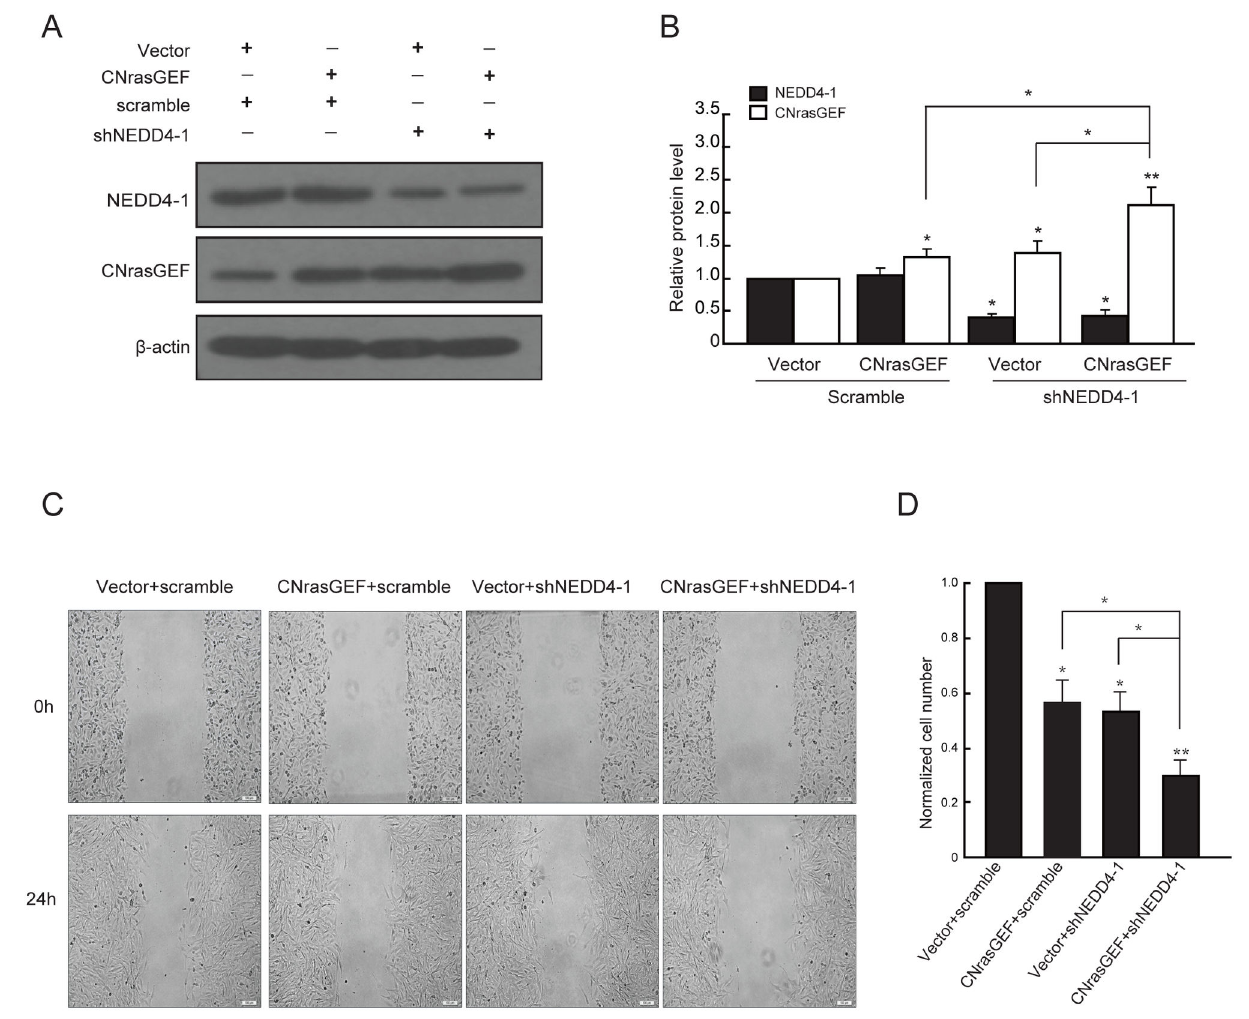
Figure 5. CNrasGEF enhances the inhibition effect of NEDD4-1 downregulation on cell migration and invasion. A) Western blotting showed the expression of NEDD4-1 and CNrasGEF after co-transfection in U251 cells. Representative western blotting analysis of total cell lysates isolated from U251 cells co-transfected with shNEDD4-1 and CNrasGEF using indicated antibodies. B) Quantitative analysis of relative protein levels of NEDD4-1 and CNrasGEF normalized to those of β-actin. C) Wound-healing assays of glioma U251 cells after co-transfection of shNEDD4-1 and CNrasGEF. Representative digital pictures were taken at 0h and 24h. D) Quantitative analysis of the number of migratory cells. Results are mean ± SEM of three independent experiments in triplicate. * P <0.05, ** P <0.01. Scale bar: